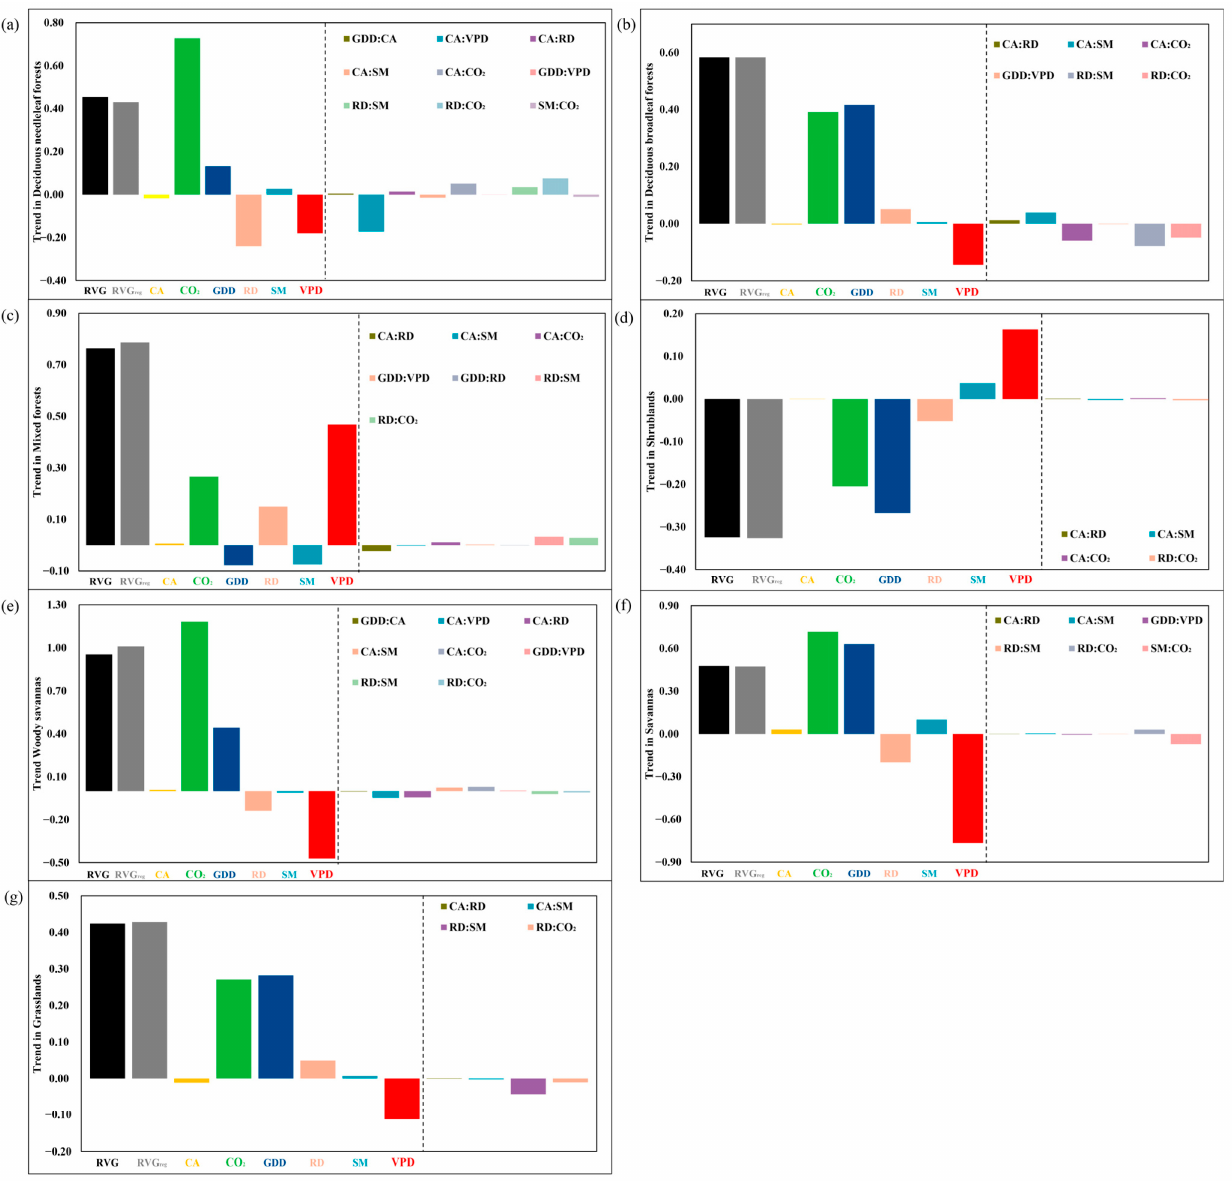
Figure 4. The bars in the graphs represent RVG trends, RVG reg trends and the contribution of CA, CO 2 , GDD, RD, SM, VPD, and interactive items (right of the dotted line) in the ( a ) DNF, ( b ) DBF, ( c )